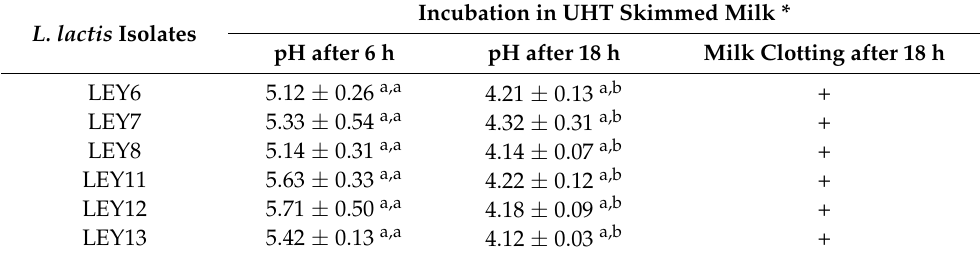
Table 3. Acidification kinetics of the L. lactis isolates. L. lactis Isolates